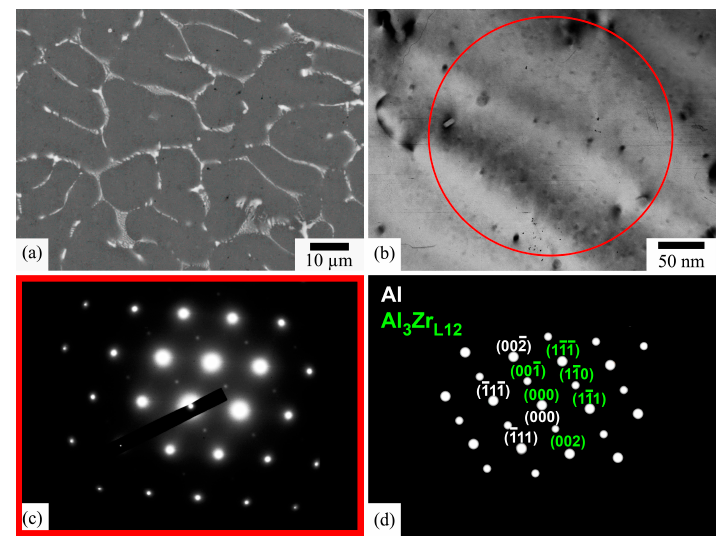
Figure 5. Transmission electron microscope (TEM) micrographs of Al-1% Fe-0.25% Si-0.3% Zr annealed at S450 with coherent L12 Al 3 Zr nano-particles: ( a ) scanning electron microscopes (SEM); ( b ) TEM; ( c ) diffraction; ( d ) schematic diffraction pattern with indexes.